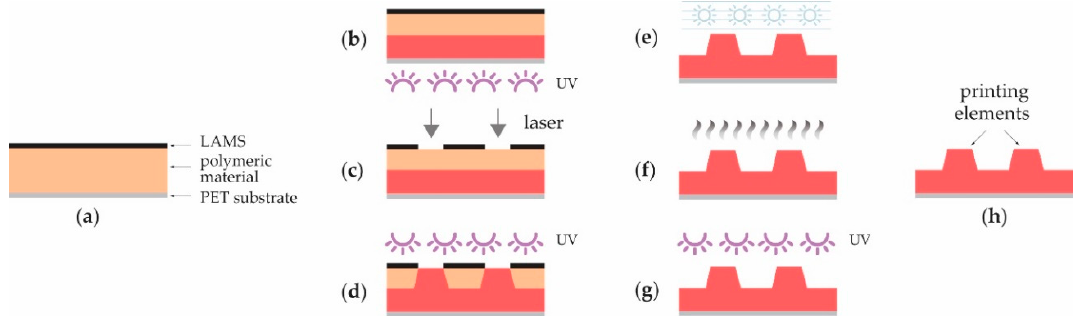
Figure 1. Production phases of the laser ablation mmask layer (LAMS)-based printing plate: ( a ) Cross-section of the photopolymer sheet, ( b ) back exposure, ( c ) ablation of the LAMS mask, ( d ) main exposure, ( e ) rinsing, ( f ) drying, ( g ) post-treatment, ( h ) finished plate.